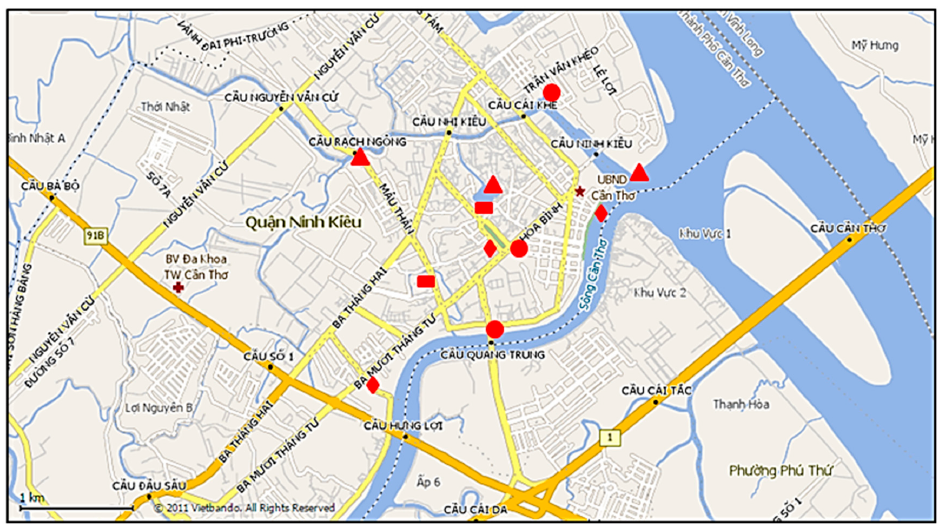
Figure 1. Water quality sampling locations in Ninh Kieu district, Can Tho (triangle indicates open water samples; circle indicates flooded and/or sewer samples; diamond indicates flooded samples; the rectangle indicates sewer samples).